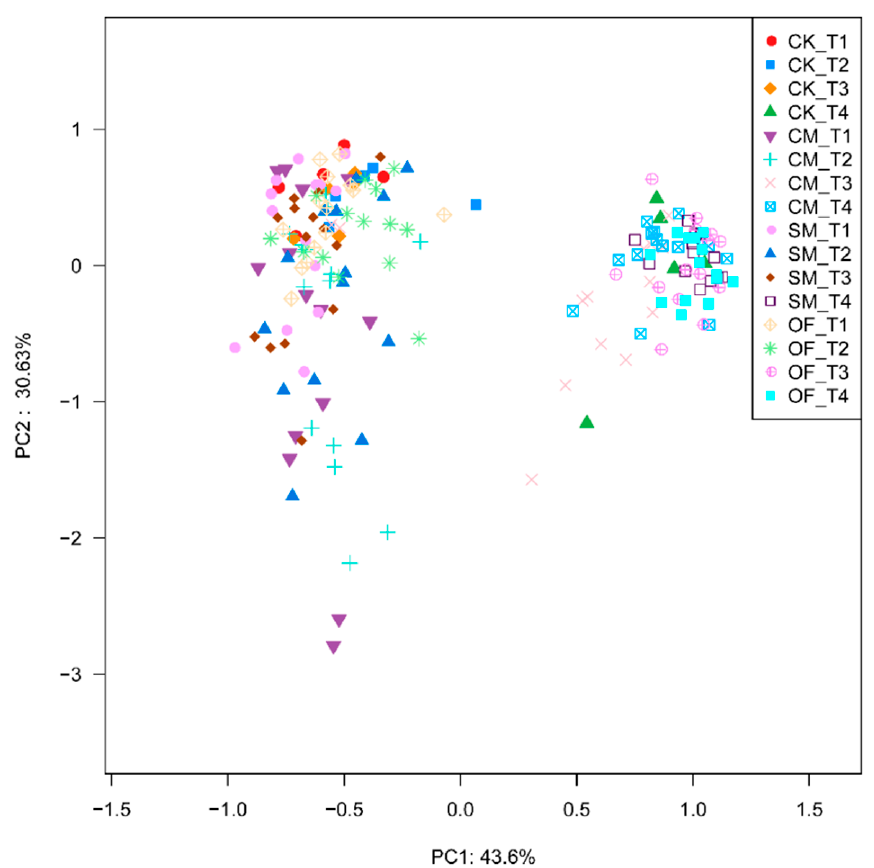
Figure 4. The PCA analysis of all treatment samples (CK: control; CM: chicken manure; OF: organic fertilizer; SM: swine manure; T1: seedling period; T2: three-leaf period; T3: filling period; T4: mature period).